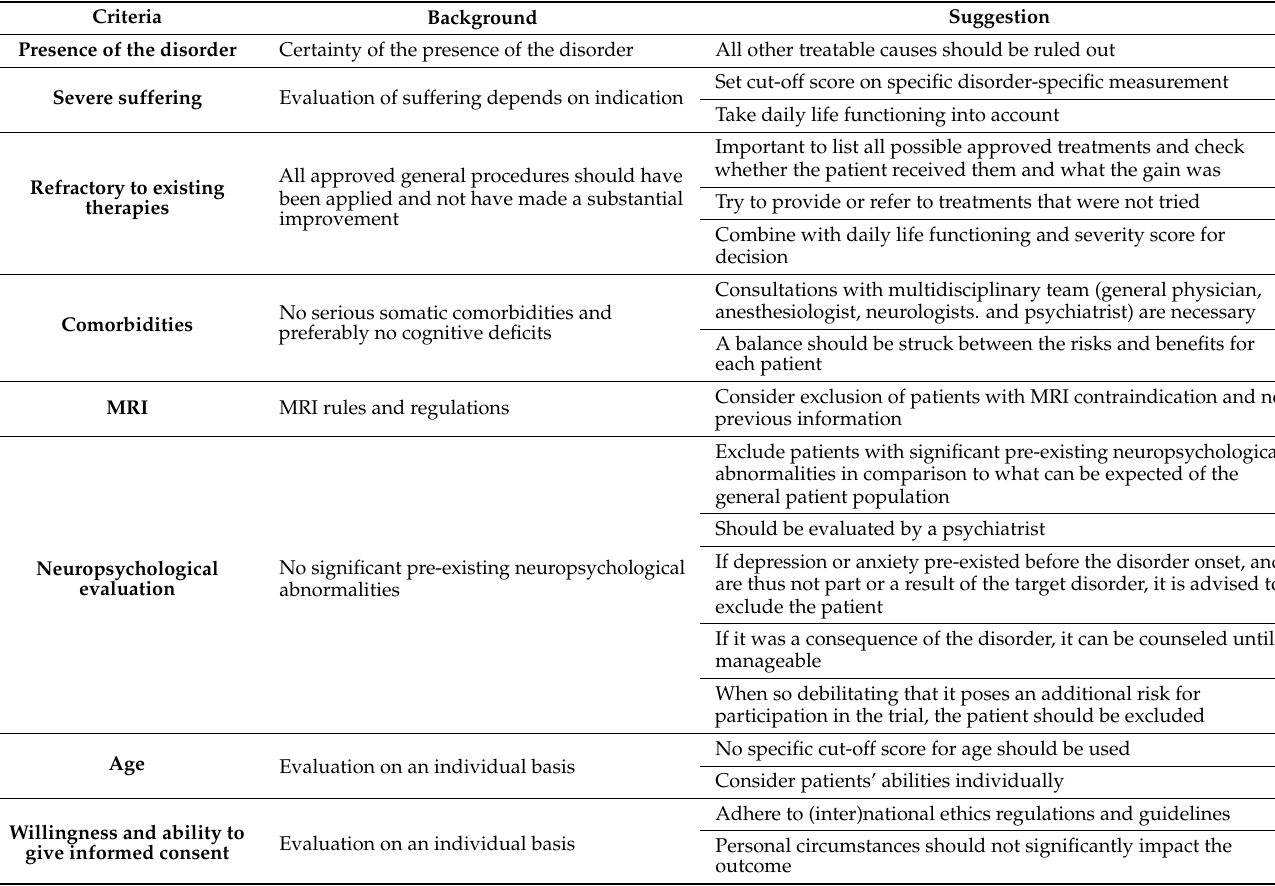
Table 2. Advised guidelines for patient selection and